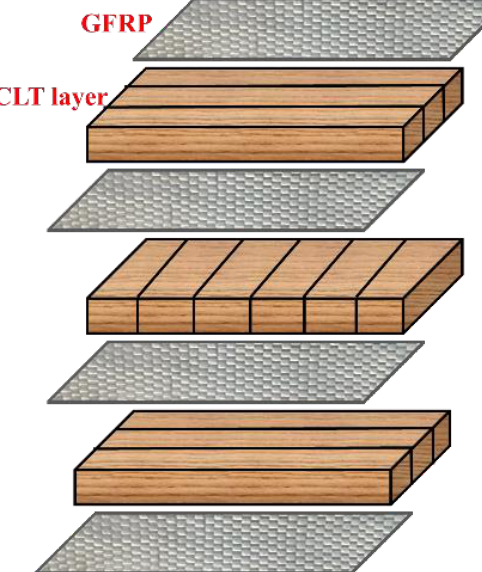
Figure 1. Schematic of adding GFRP to CLT samples.